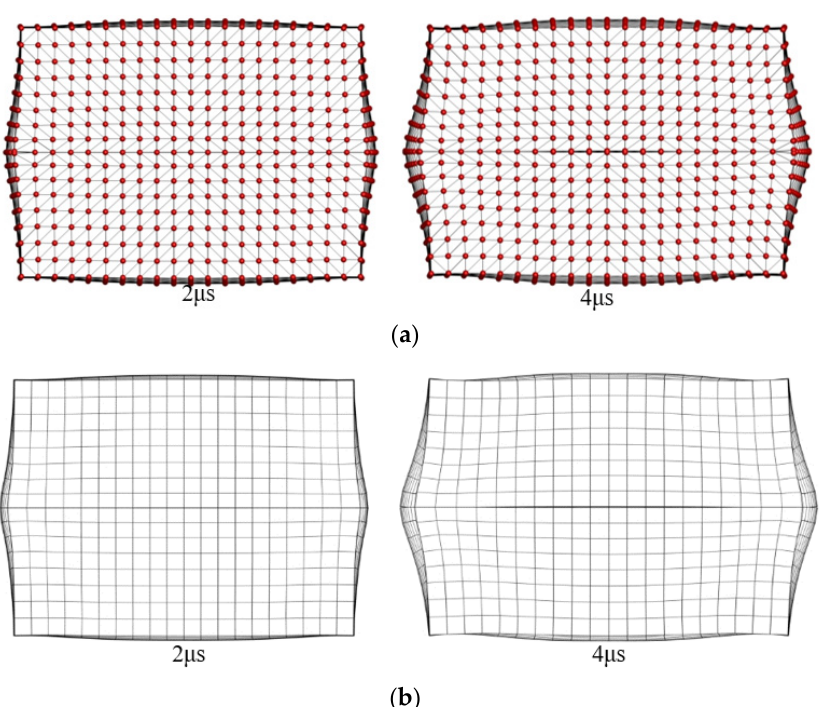
Figure 11. Deformed shapes of the blocks calculated by different methods (Side view): ( a ) Present algorithm; ( b ) FEM.